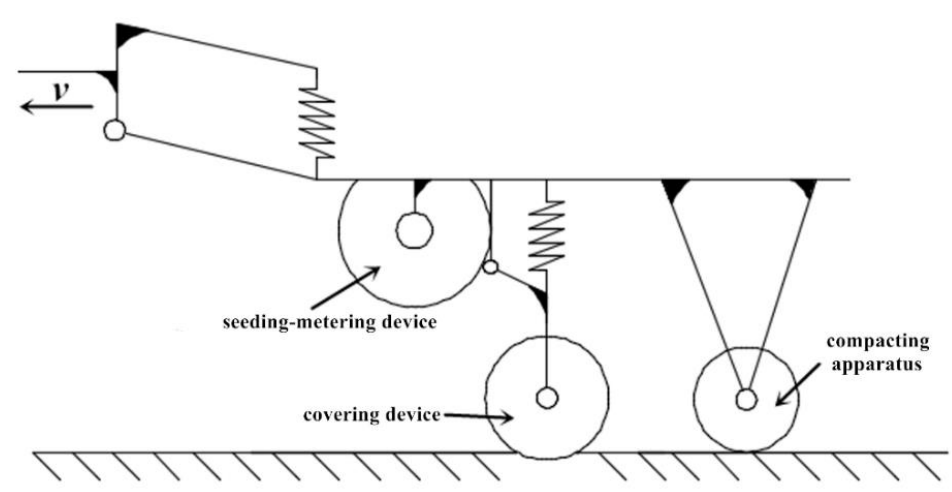
Figure 1. Motion diagram of the seeding mechanism.